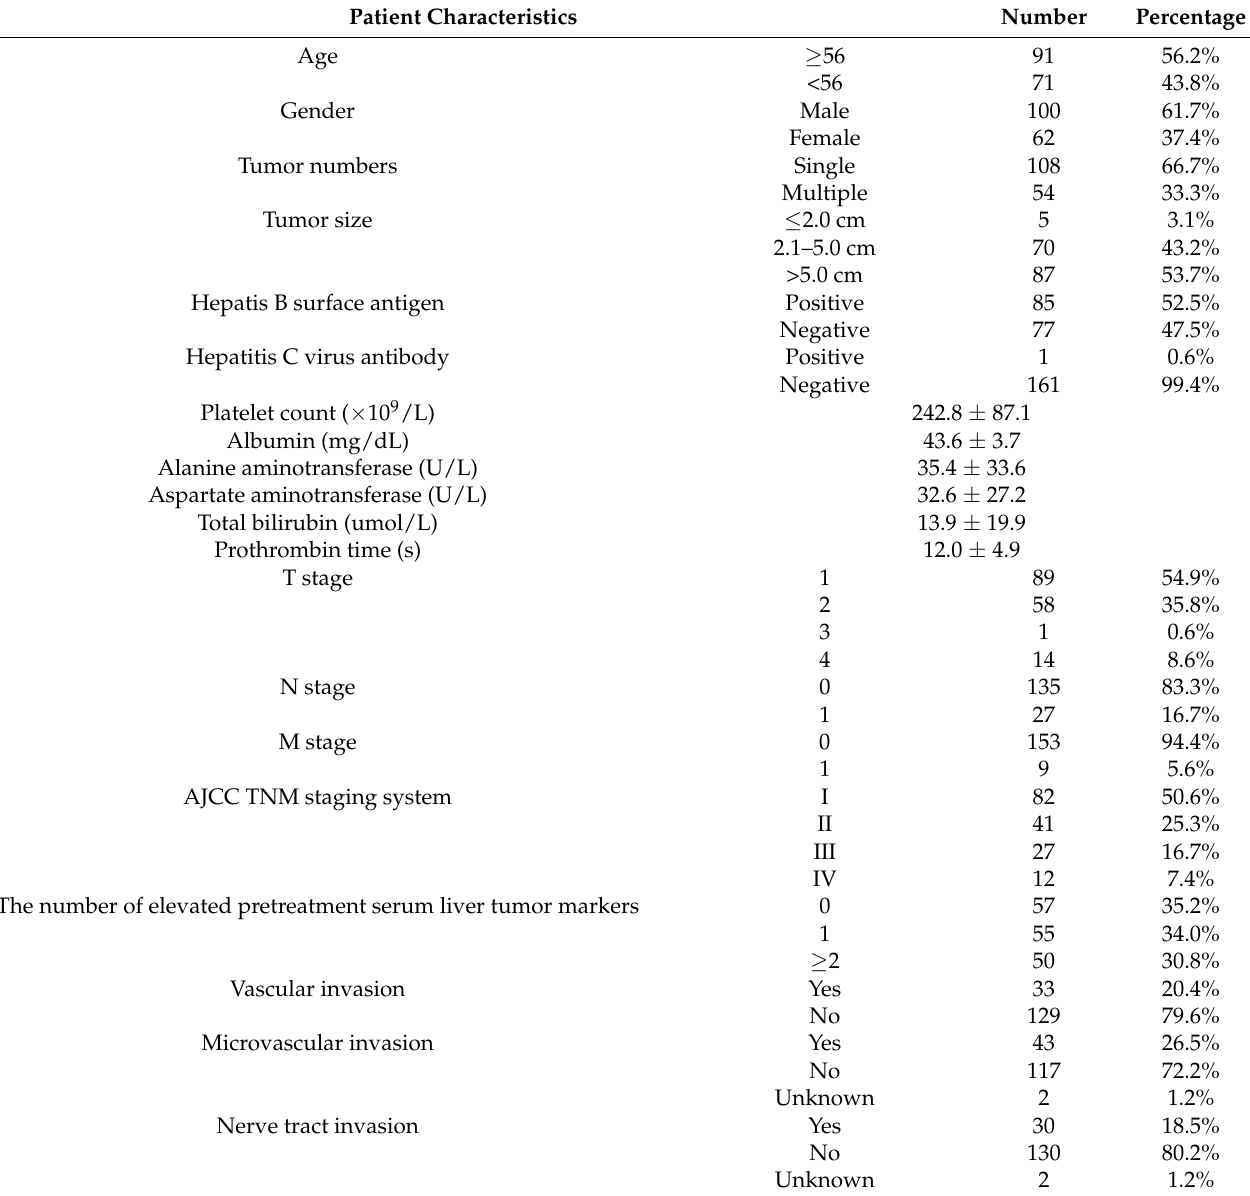
Table 1. Demographical characteristics and clinical data of the